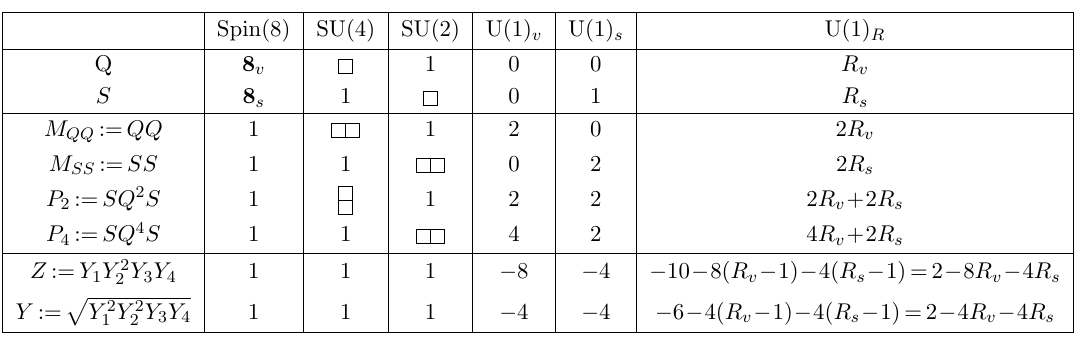
Table 2 . 3d N = 2 Spin(8) theory with ( N v ;N s ;N c ) = (4 ; 2 ;